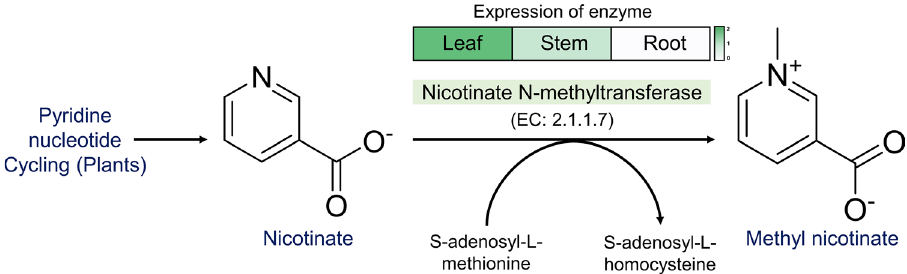
Figure 4. Trigonelline biosynthesis pathway and relative abundance across tissues of the transcript encoding the enzyme-Nicotinate N -methyltransferase (represented as heatmap of average TPM value in log2 scale, in green-white colour scale). The pathway has been adapted from Plant Metabolic Network (PMN), https:// pmn. plant cyc. org/ PLANT/ NEW- IMAGE? type= PATHW AY& object= PWY- 5110& detail- level=3, on www. plant cyc. org, Aug 12,